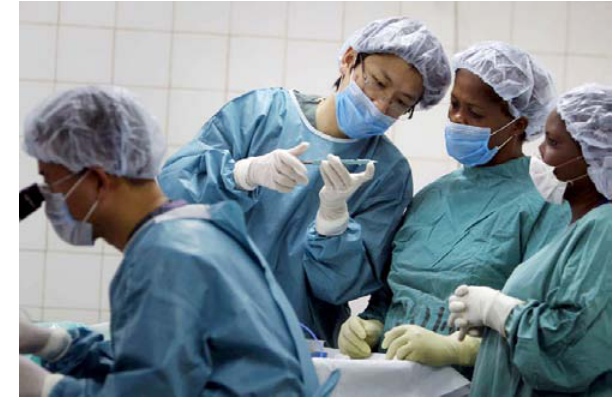
Global Fund to Fight AIDS, Tuberculosis and